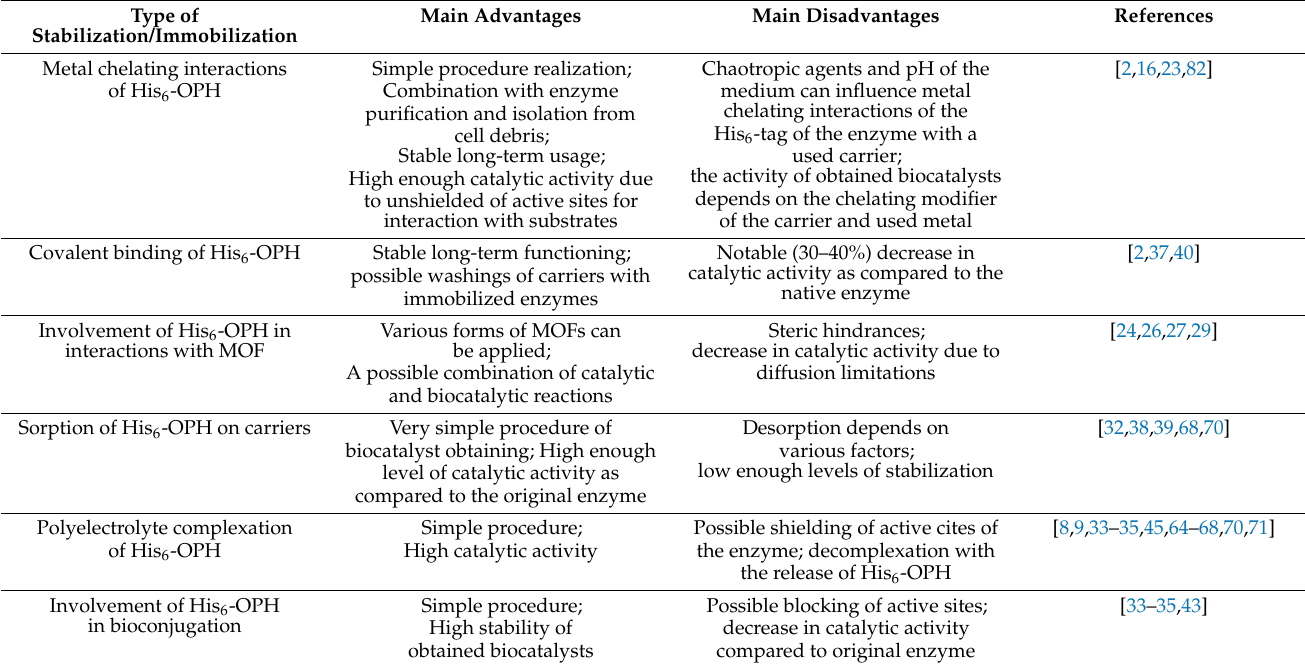
Table 3. General characteristics of the biocatalysts obtained by various methods of His 6 -OPH